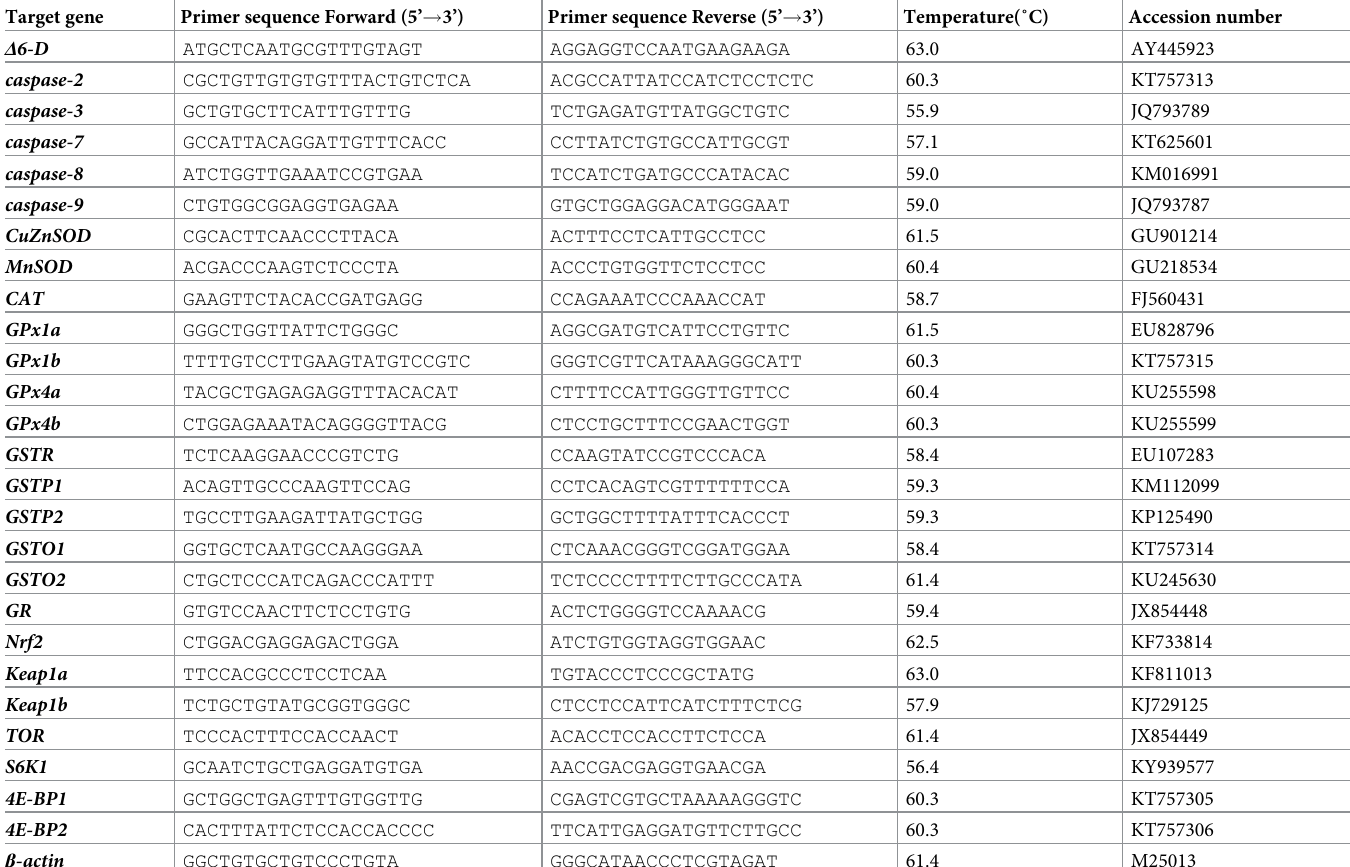
Table 2. Real-time PCR primer sequences 1